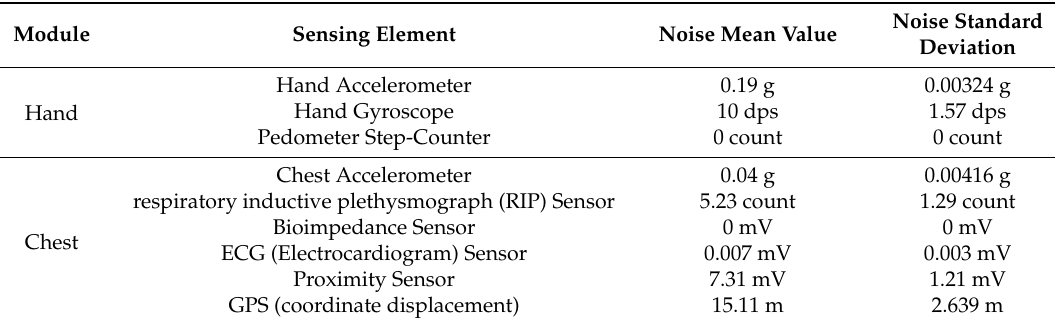
Table 1. Idle test noise characterization results.